Question: Based on the figure, does the quantity rise or fall?
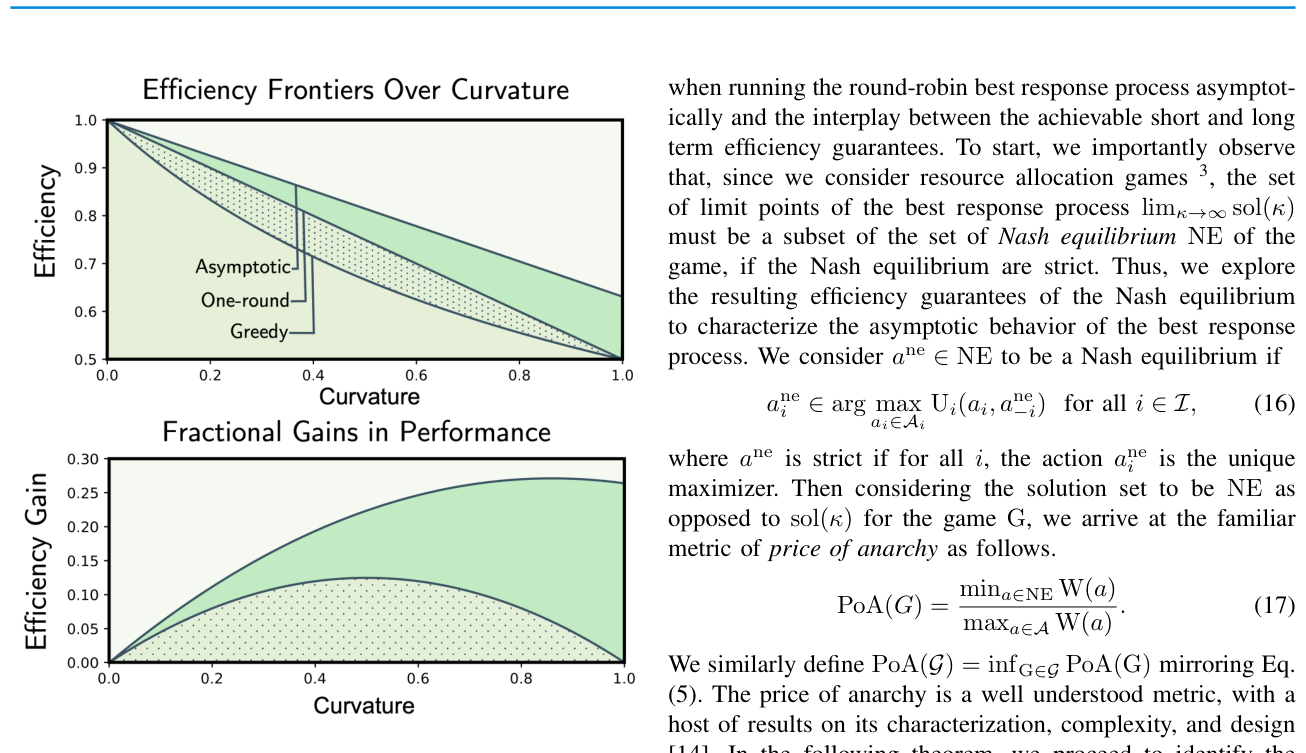
Answer: increasing